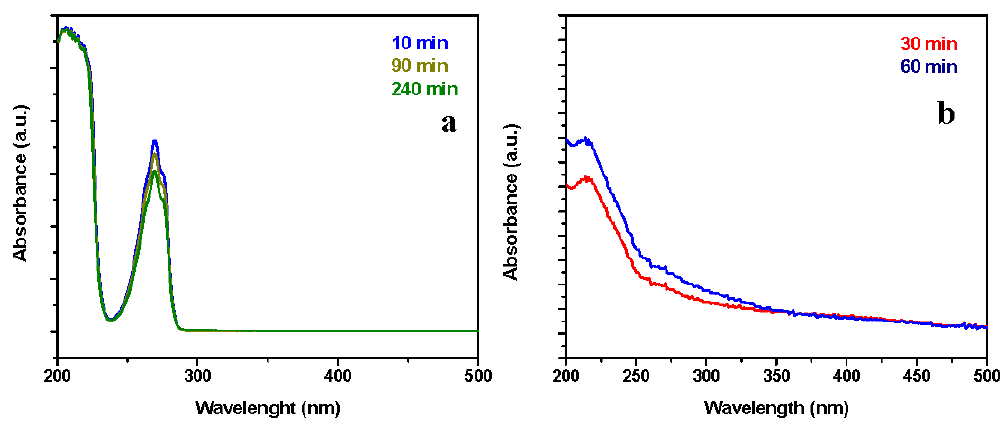
Figure 12. UV-spectra of the reaction media (reaction solutions at specific times) at 95 °C, 1000 mg/L phenol concentration, 0.4 g/L of HCL resin ( a ) and HCL nanocomposite ( b ).